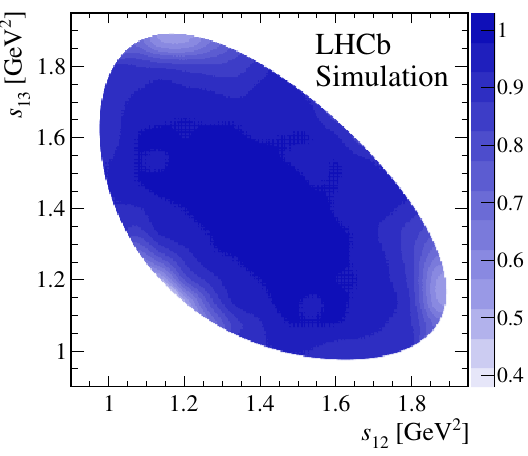
Figure 3 . Total e(cid:14)ciency, normalised to unity, for the D + ! K (cid:0) K + K + signal over the Dalitz plot, including the geometrical acceptance and the reconstruction, selection, PID and trigger e(cid:14)ciencies. momentum, pseudorapidity and event charged-particle multiplicity. The trigger e(cid:14)ciency is obtained from simulation, with a correction factor determined from data to account for the small mismatch between the performance of the trigger in data and